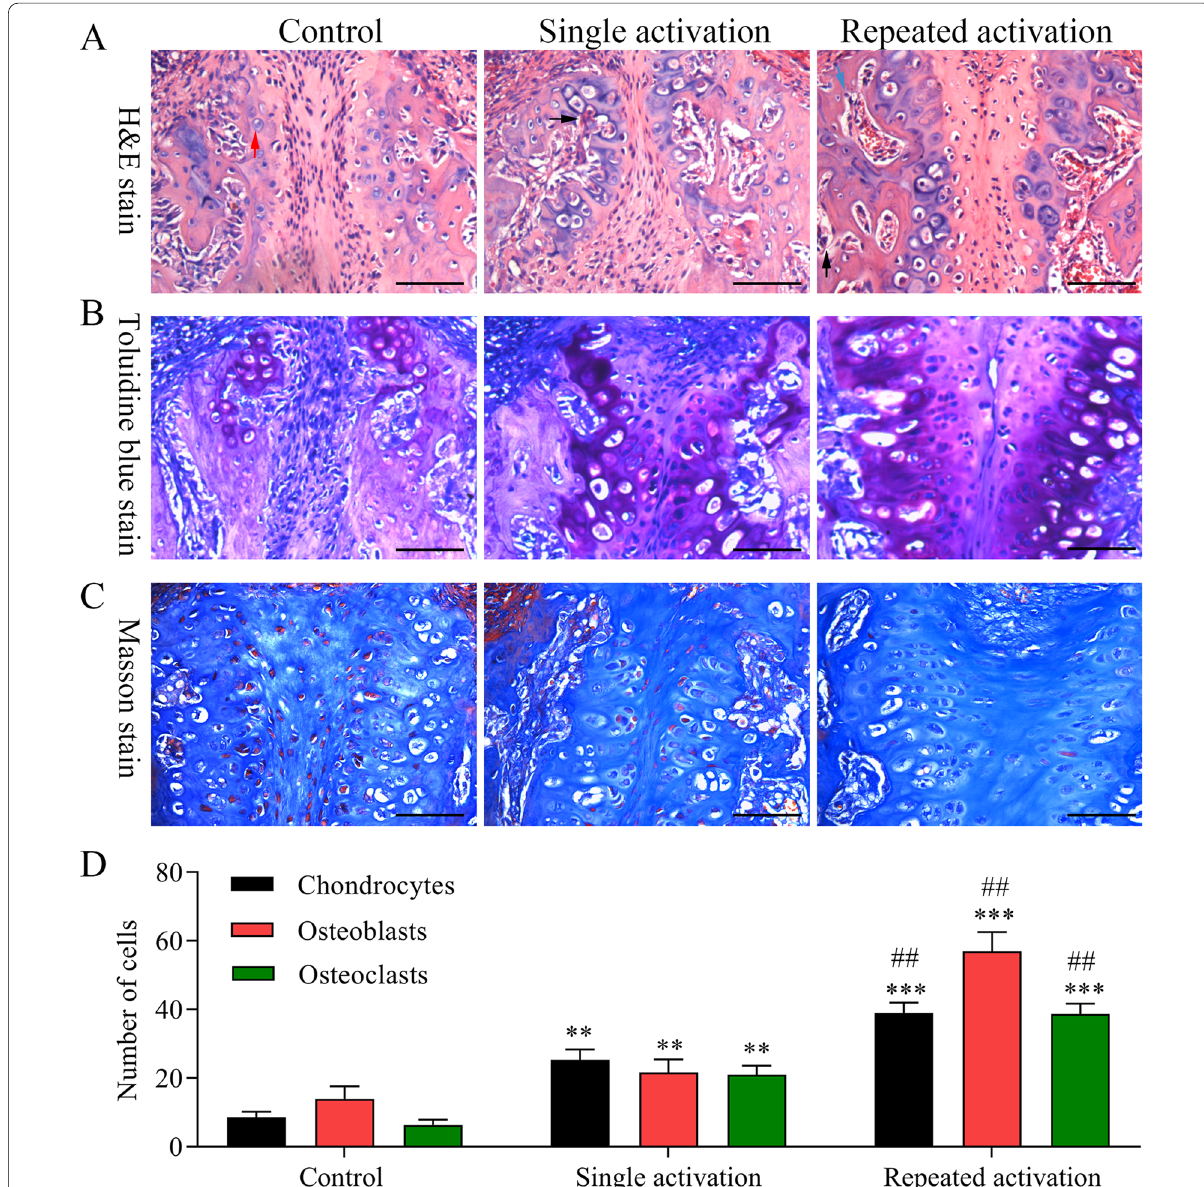
Fig. 2 The effects of maxillary expansion on bone remodeling in rats. The rats were divided into control, single activation and repeated activation groups, respectively. A The conditions of palatal suture tissue remodeling and widening were assessed by H&E staining. Magnification, 400 . B The × chondrocytes in mid-palatal suture were evaluated by toluidine blue staining. Magnification, 400 . C The histological fibrosis grades of mid-palatal × suture in rats were measured by Masson staining. Magnification, 400 . D The number change of chondrocytes, osteoblasts and osteoclasts was × counted in each group based on the H&E staining results. ** P < 0.01, *** P < 0.001 versus control group; ## P < 0.01 versus single activation group. The red arrow indicates chondrocyte, the black arrow indicates osteoclast, and the blue arrow indicates